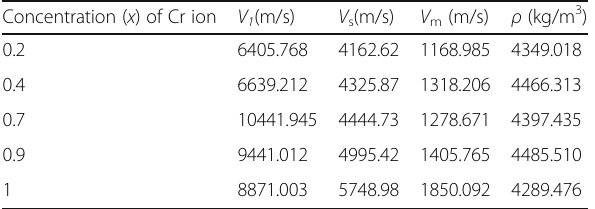
Table 1 Variation of density ( ρ ), longitudinal ( V 1 ), shear ( V s ), and average sound velocity ( V m ) with increasing Cr 3+ ion concentration Concentration ( x ) of Cr ion V 1 (m/s) V s